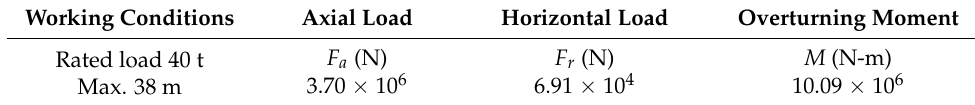
Table 2. Total load on the slewing bearing when lifting 40 t load with an amplitude of 38 m. Working